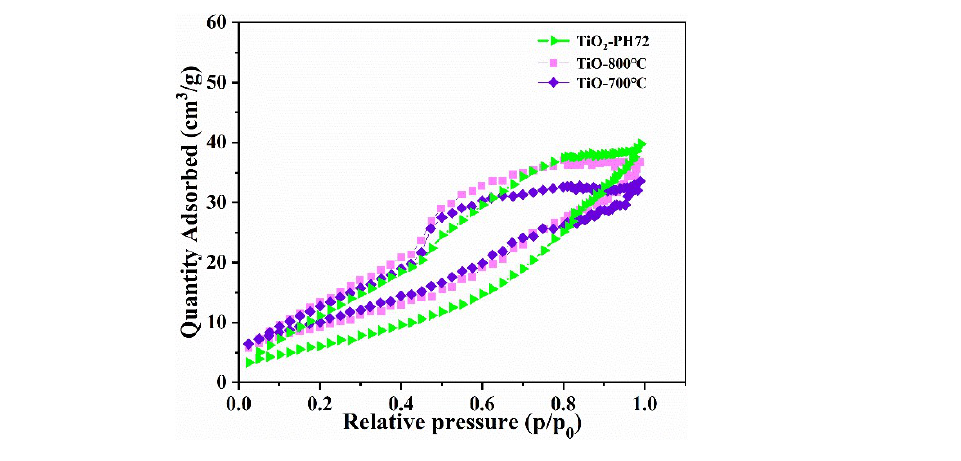
Figure 2. N 2 gas adsorption/desorption isotherm of all samples; the inset is the corresponding pore-size distribution.